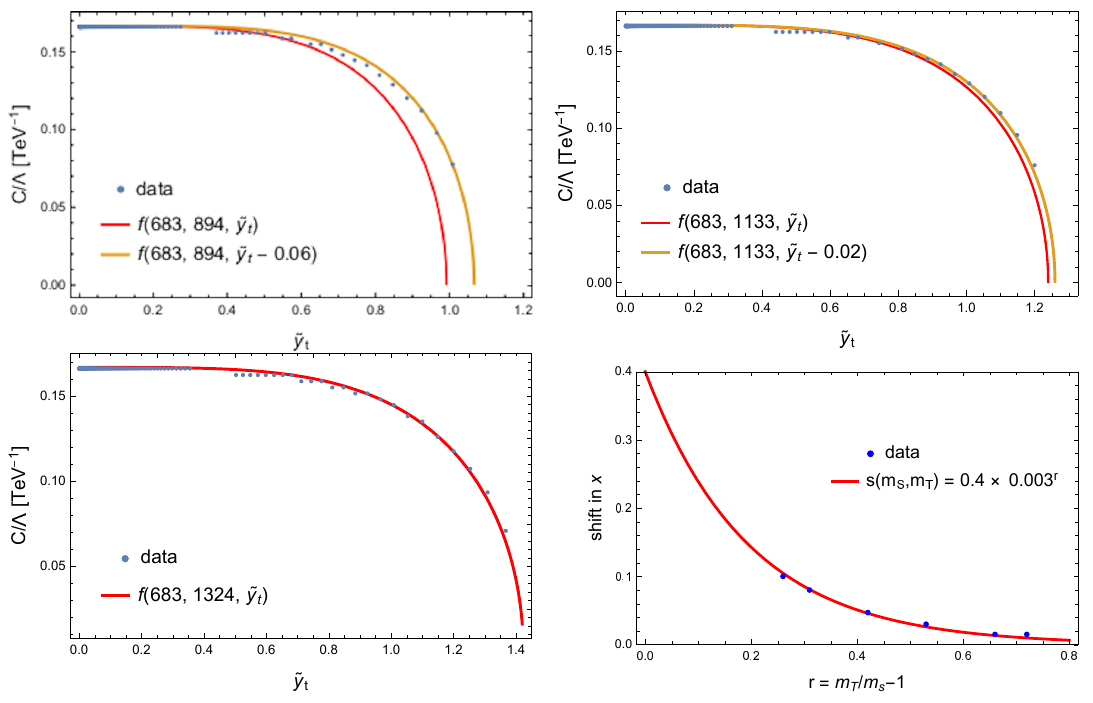
Figure 11 . Results of our fitting procedure for an example mass point featuring m S = 682 . 6 GeV, with varying r values (top row and bottom left figures), and the corresponding exponential fit to the deviation (bottom right). The fitting function f from eq. (2.11) fits well for more separated masses of S and T (bottom left figure), but when the mass difference is small (figures of the upper row) the function deviates from the observed values. The function can be shifted in the positive x direction (that is, in ˜ y t ) in order to re-establish agreement. In the bottom right plot, the deviation is fitted to a decreasing exponential, where the largest shifts in ˜ y t are necessary for lower r , and the shift becomes negligible above r = 0 . 8 . All points yield the correct relic